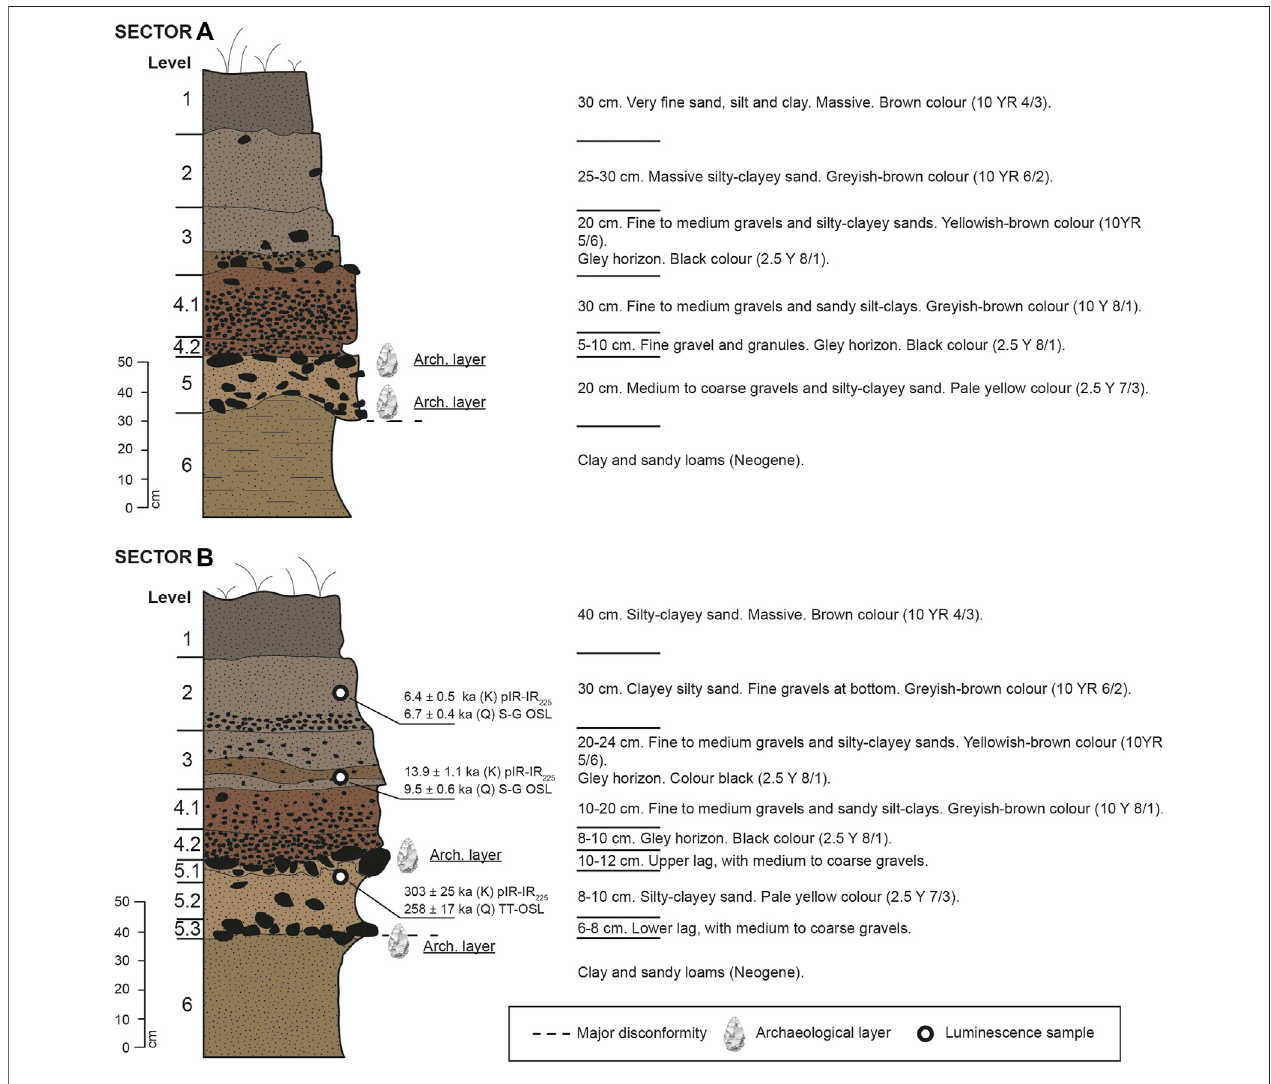
FIGURE 3 | Stratigraphic columns of sectors A (above) and B (below) of El Sotillo.